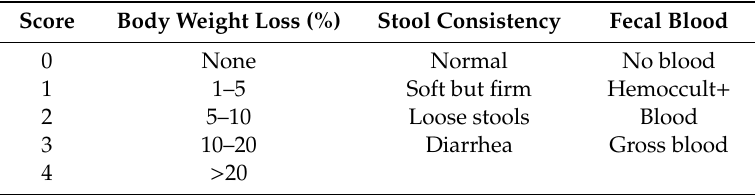
Table 1. Scores of the disease activity index